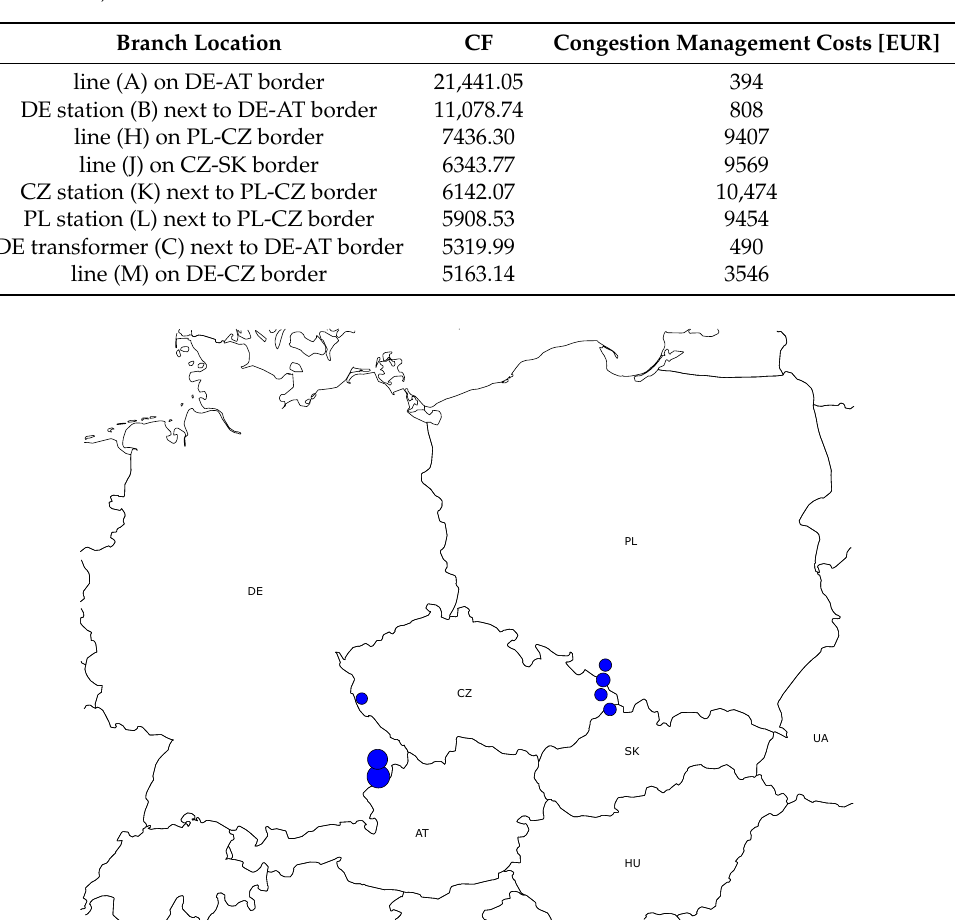
Table 4. Top 8 (cut-off at CF = 5000) branches according to the congestion factors and congestion management costs, aggregated over 24 grid scenarios, obtained after placing a new PST at a given Table 3 above). Source: own calculations.